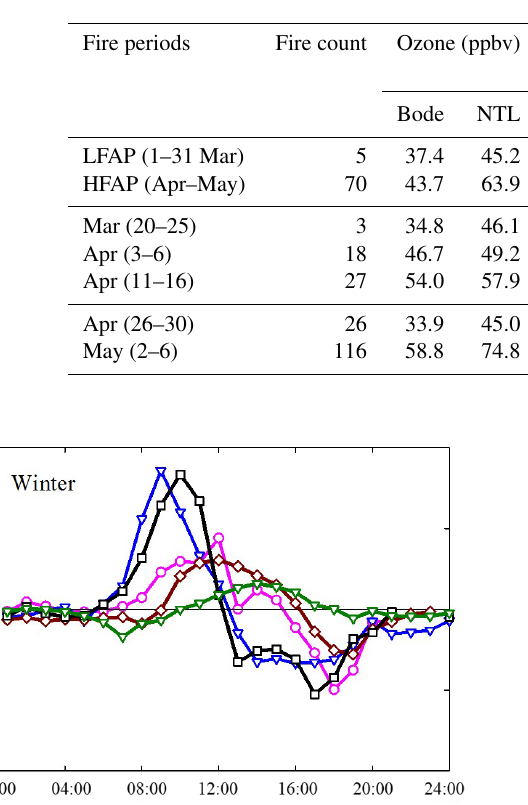
Table 4. The average O 3 and CO mixing ratios at Bode, Nainital and Pantnagar with GFED average biomass burning emissions over the Kathmandu region during different periods.